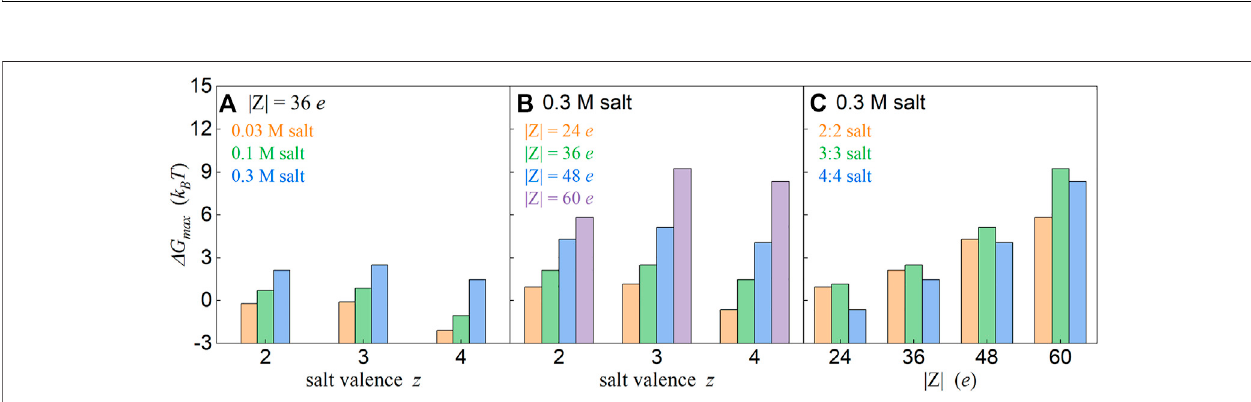
FIGURE3|(A – C) Effectivepotentialsofmeanforce Δ G(x)betweenequallyandoppositelychargedparticleswithdifferentchargeparticles|Z|insymmetrical2:2,3: 3, and 4:4 salt solutionsfrom the MC simulations. The insets are the relative charge fraction Δ f (cid:1) f(x) − f(x ref ) of condensed counterions obtained from the MC simulations as a function of separation x between two particles. The salt concentrations are 0.3 M, and the particle charges and ion valences have been shown in the respective panels. The reference separation was taken as x ref (cid:1) 45 Å.